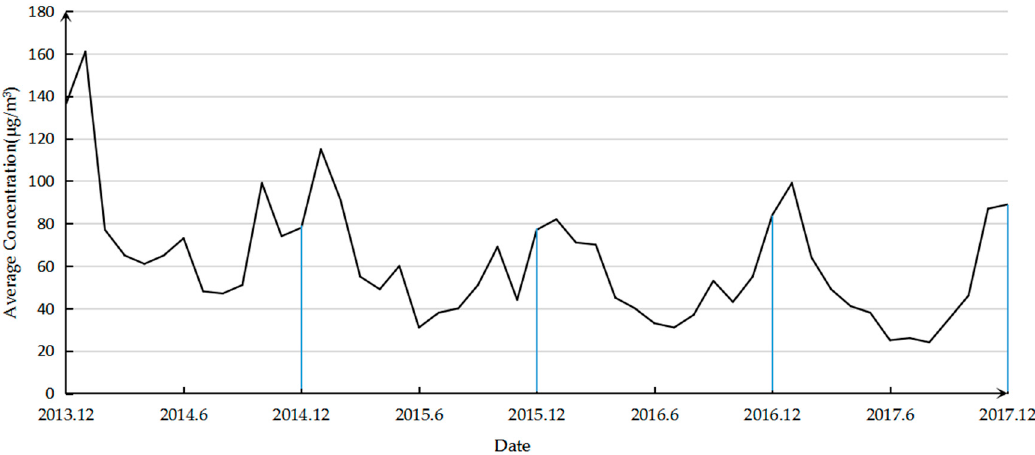
Figure 2. Changsha PM 2.5 monthly variation curve from December 2013 to December 2017.